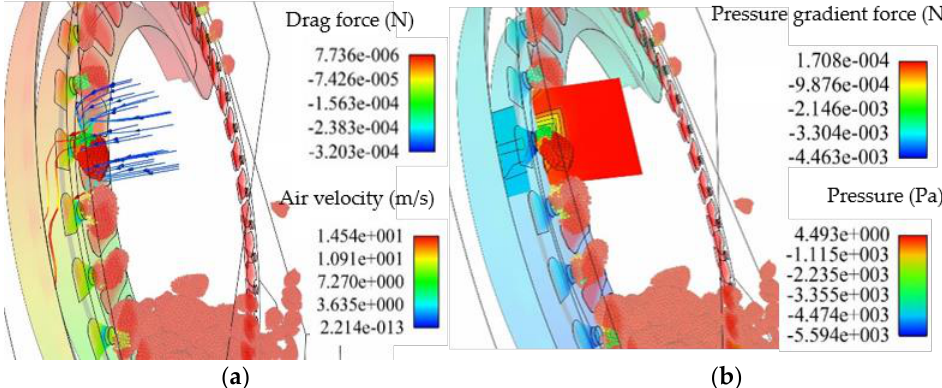
Figure 9. Coupled gas-solid EDEM-CFD simulation of the maize seed meter. ( a ) Drag force of the seeds afforded in the flow; ( b ) Gradient force of the seeds afforded under the pressure.